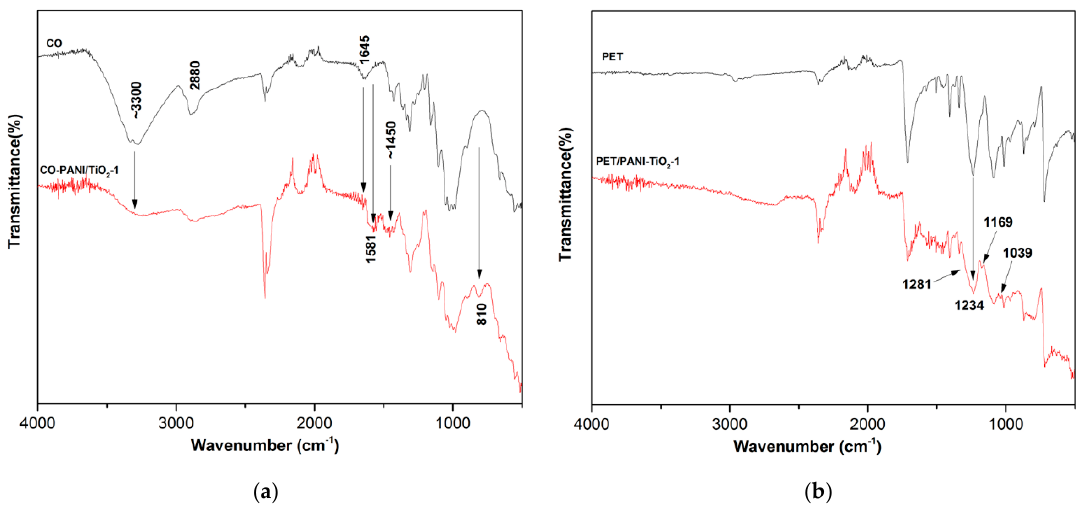
Figure 3. FTIR spectra of ( a ) CO and CO-PANI/TiO 2 -1 samples and ( b ) PET and PET-PANI/TiO 2 -1 samples.